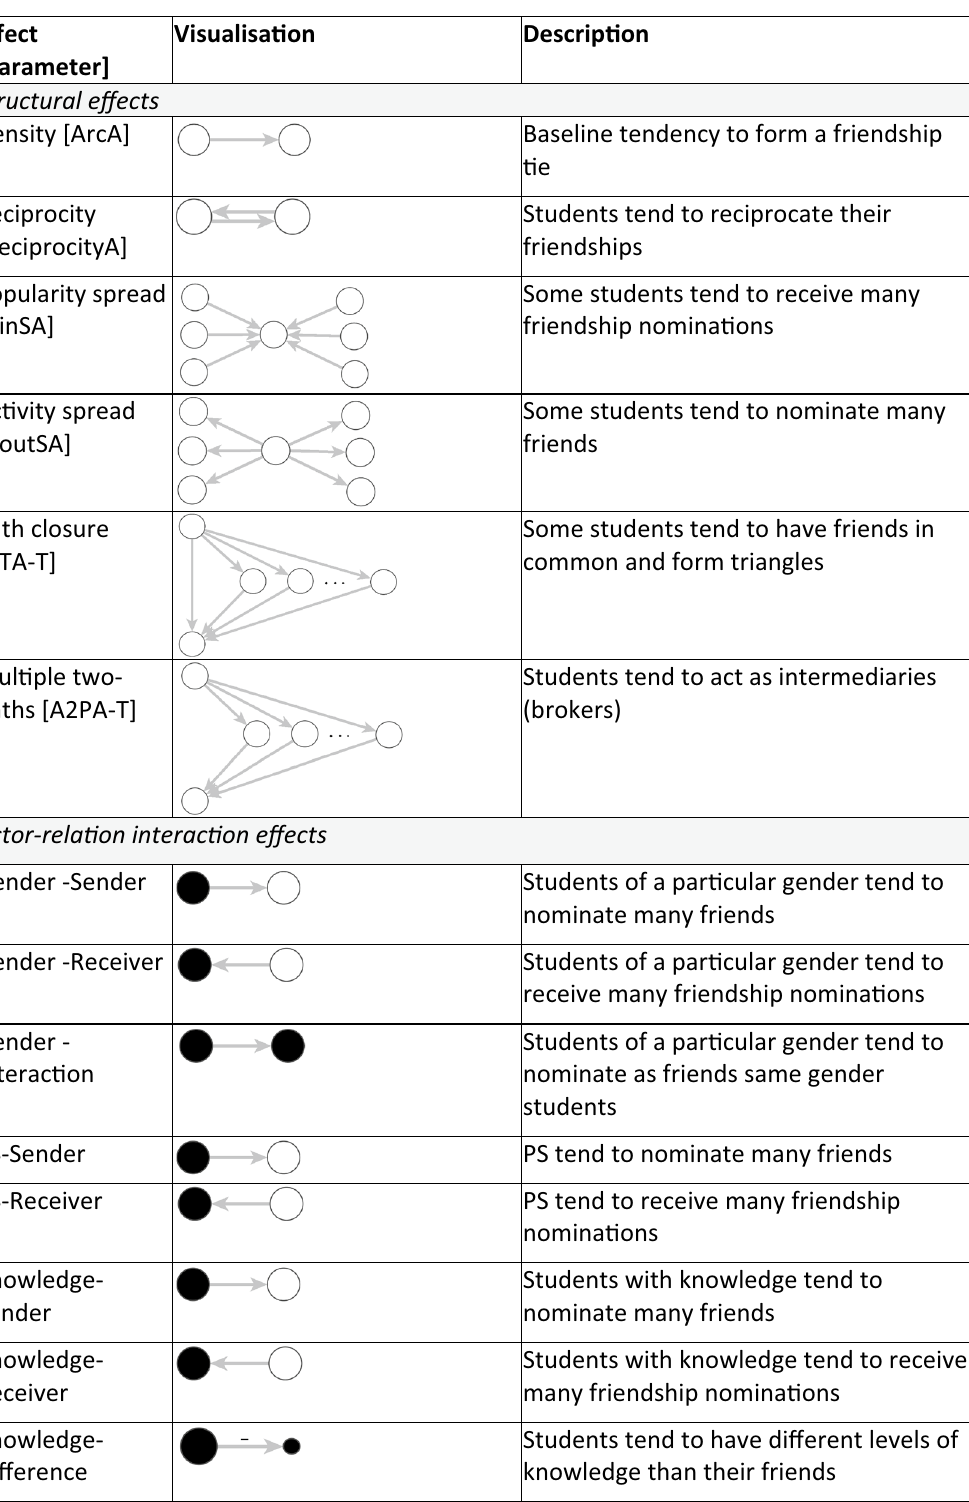
Figure 2. Parameter effects, visualisation and